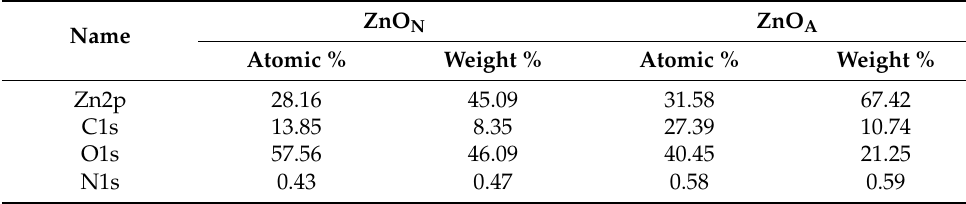
Table 2. Atomic surface composition determined by XPS.